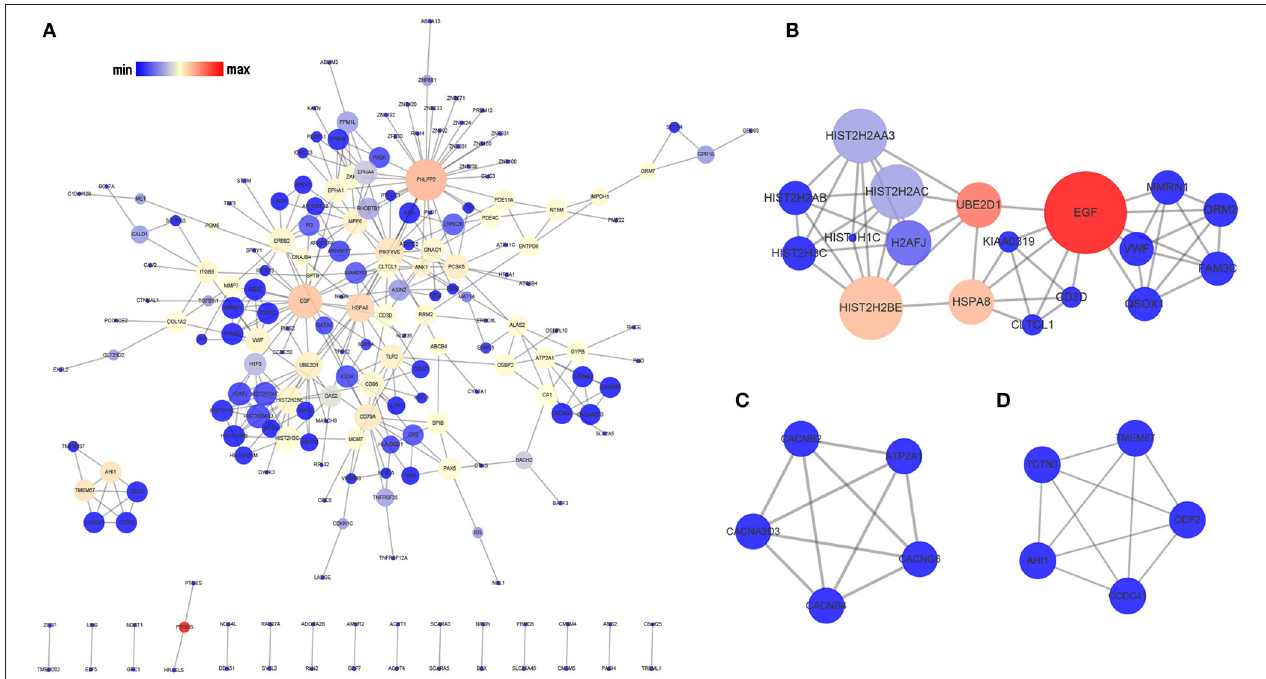
FIGURE 3 | Analysis of the PPI network of the OMRGs. The nodes represent the OMRGs in the PPI network, and the lines show the interaction between the OMRGs . (A) PPI network of the OMRGs. (B) module 1. (C) module 2. (D) module 3. The node size correspond to degree of the node, while the node color denotes betweenness